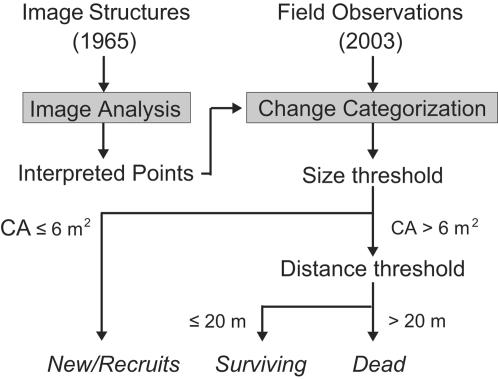
Flowchart. Image structures resembling trees are interpreted and represented as points. Together with trees recorded in field, all points are categorized as belonging to one of three Change Categories. In this process a size (Canopy Area of 6 m2) and distance (20 m) threshold was applied to compensate for GPS inaccuracies and limited image resolution [32]. Trees recorded in 2003 with CA ≤6 m2 are automatically categorized as new.